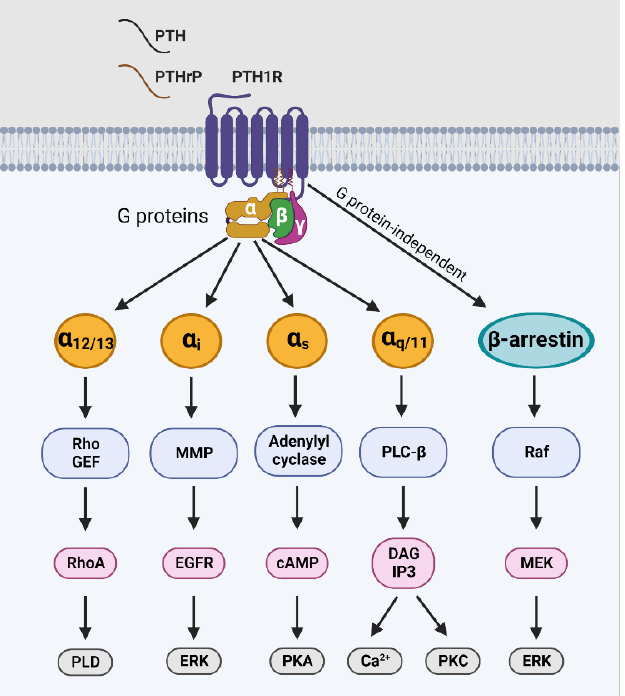
Figure 2. Diagram of ligand binding with PTH1R and the downstream signaling pathway. When PTH or PTHrP binds to PTH1R, it induces a conformational change in the receptor, leading to the activation of diverse downstream signal transduction pathways, via either G protein-dependent or -independent/β-arrestin-dependent mechanisms [52]. GEF: guanine nucleotide exchange factor; PLD: phospholipase D; MMP: matrix metalloproteinase; EGFR: epidermal growth factor receptor; MEK: mitogen-activated protein kinase; ERK: extracellular signal-regulated kinase; PKA: protein kinase A; PKC: protein kinase C; PLC-β: phospholipase C-β; DAG: diacylglycerol; IP3: inositol 1,4,5- triphosphate.